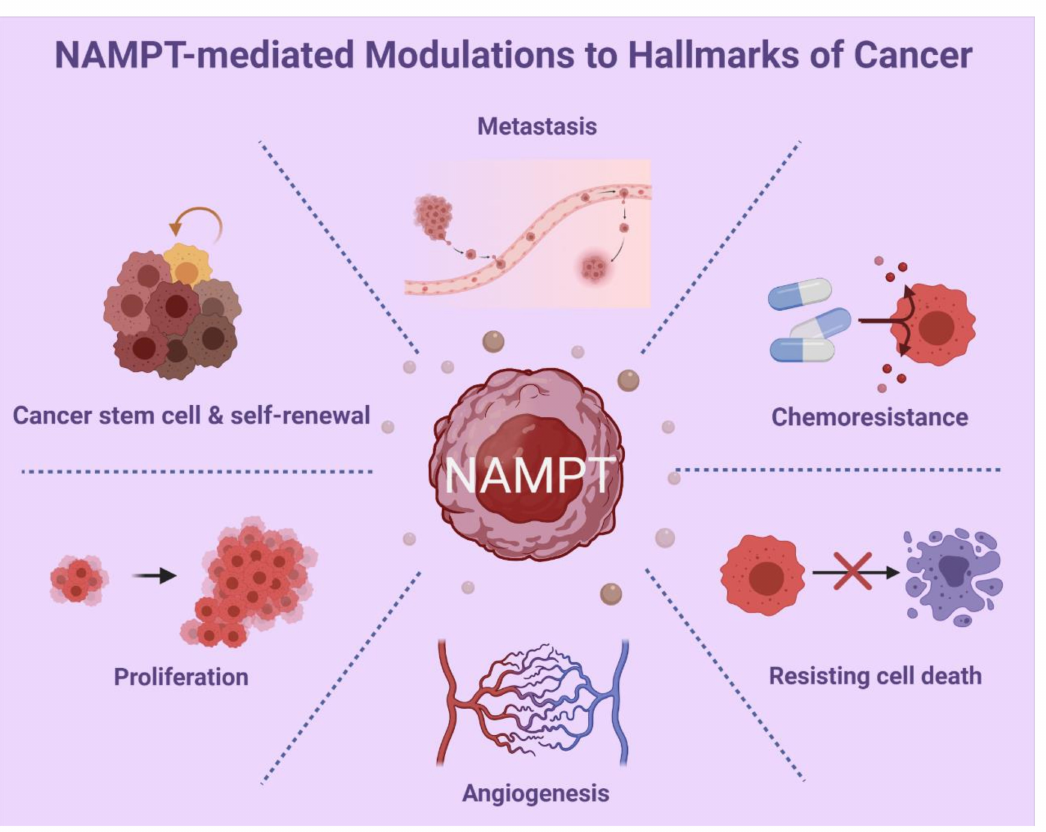
Figure 6. The representative scheme of NAMPT’s modulations to hallmarks of